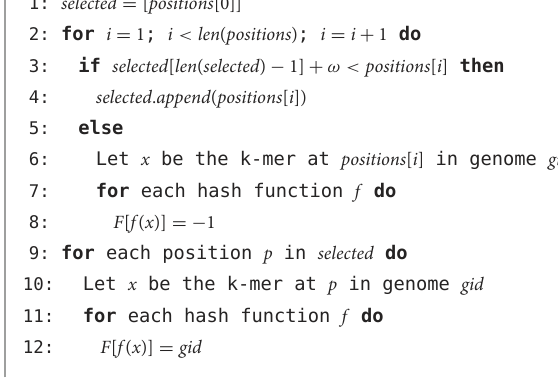
Algorithm 2. Reduce( F , gid , positions